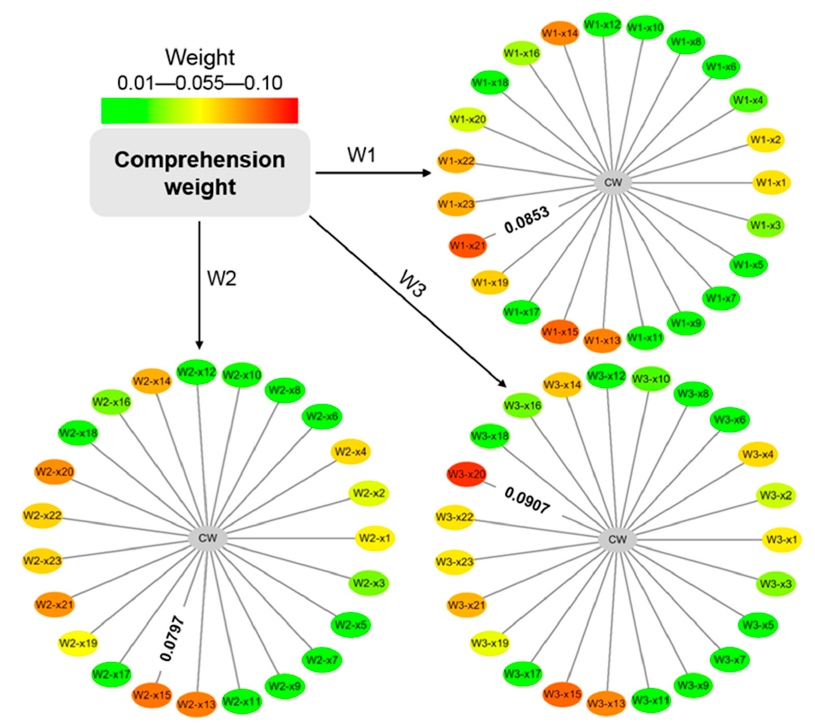
Figure 6. Comprehensive weight value of different methods.